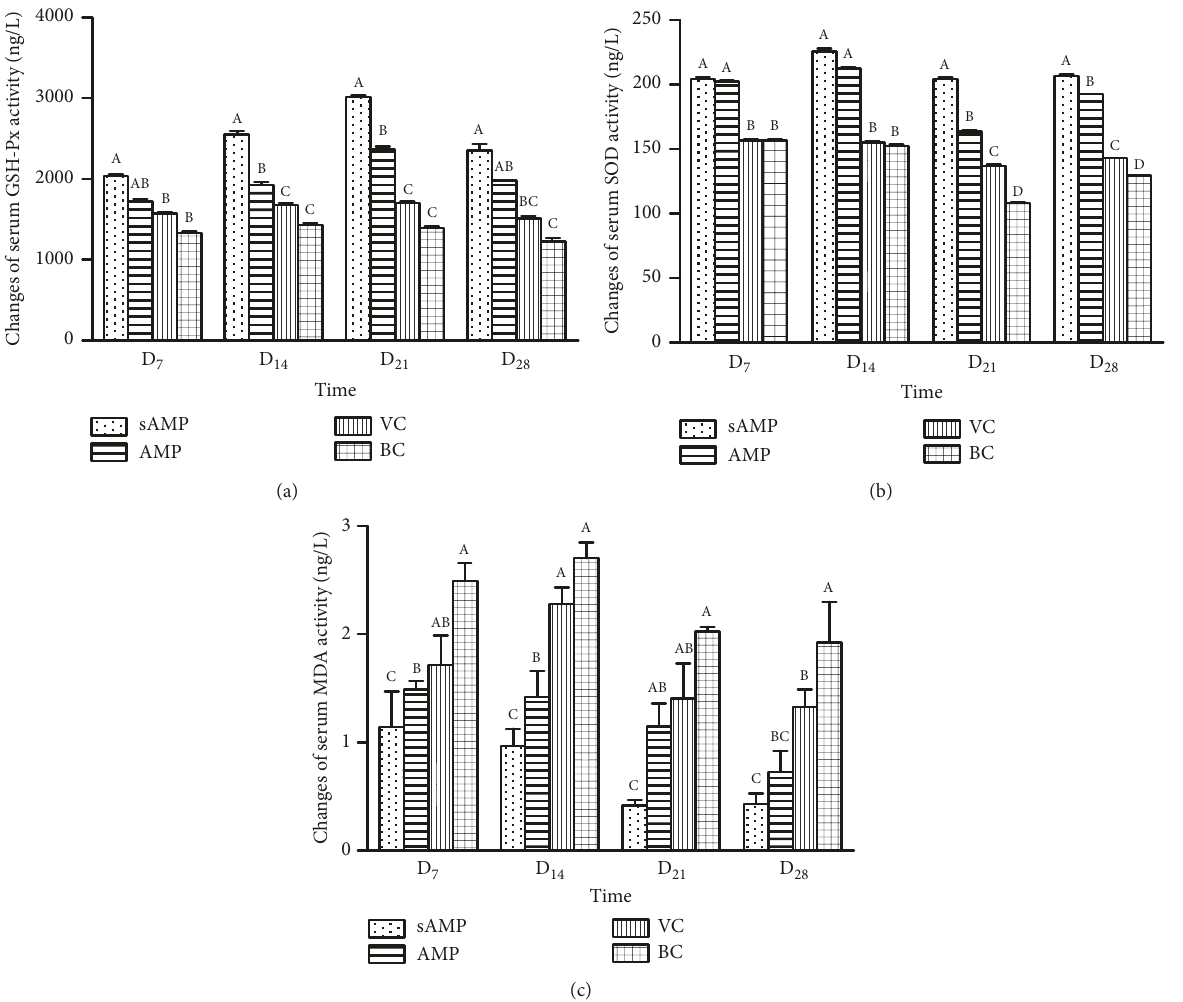
Figure 5: The changes of serum GSH-Px activity (a), SOD activity (b), and MDA content (c) in vivo; bars without the same superscripts (A–D) differ significantly ( p <